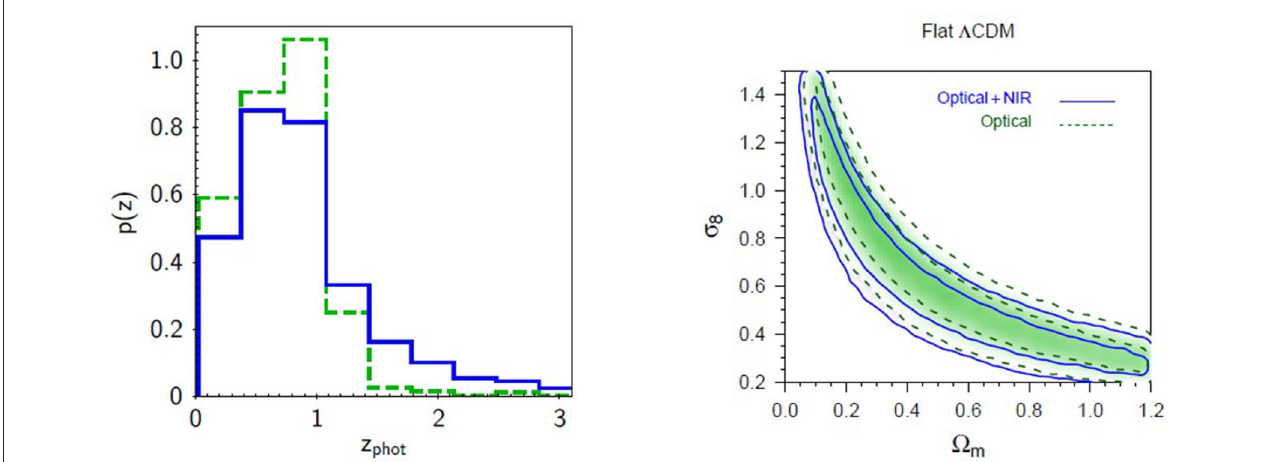
FIGURE 5 | Figure from Fu et al. (2018). (Left) The normalized histogram of photo-z estimated using photo-z derived using, four optical bands (green dash line) and eight (optical plus near-IR) bands (blue solid line). (Right) Diagram of marginalized posterior density contours (68.3 and 95.5%) for (cid:127) M and σ 68 in the case of flat 3 CDM. The blue contours are the constraints related to the 8-band photo-z, while for blue contours, the results using 4-band photo-z are shown.